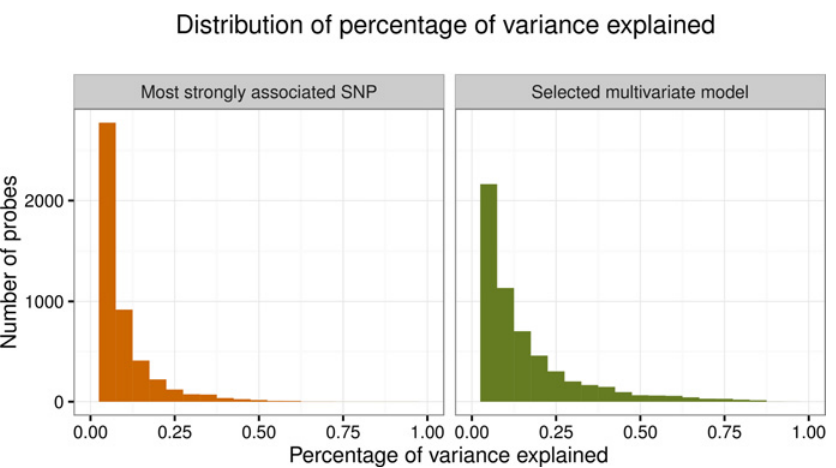
Fig 4. Distribution of percentage of variance explained. Percentage of variance explained (model r 2 ) by the most strongly associated eSNP and by the best set of eSNPs selected using multivariate model selection for the 7,280 heritable probes with local or distal